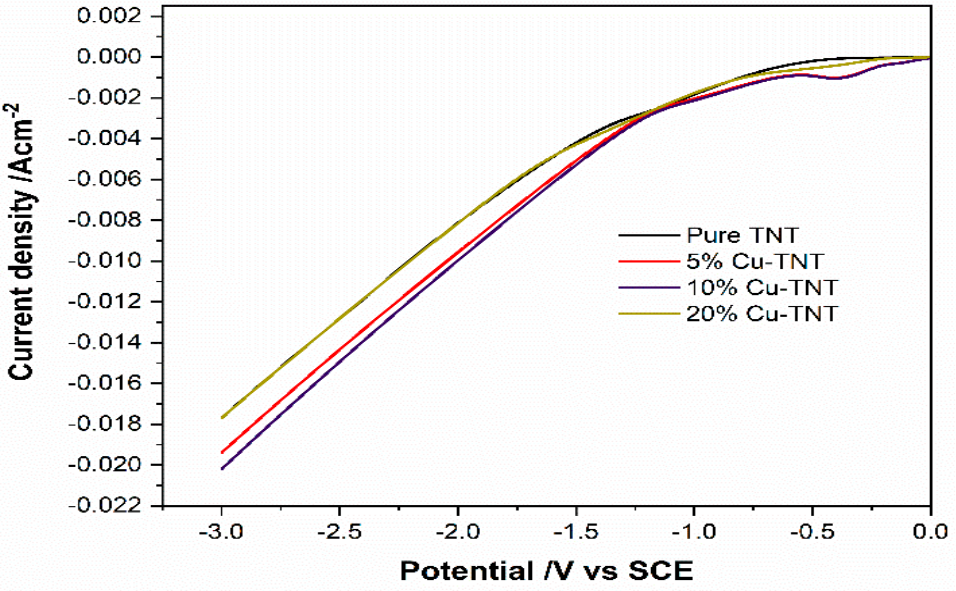
Figure 5. Linear sweep voltammetry for the prepared catalysts in aqueous 0.5 NaHCO 3 .